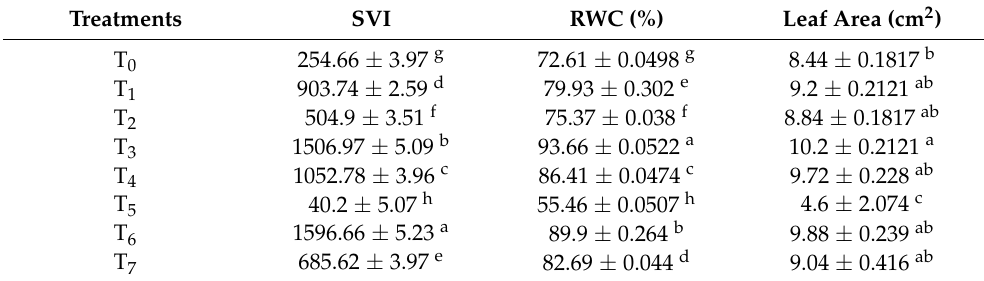
Table 2. Effect of SWE on mitigating salt stress on SVI, RWC(%) and leaf area (cm 2 ).